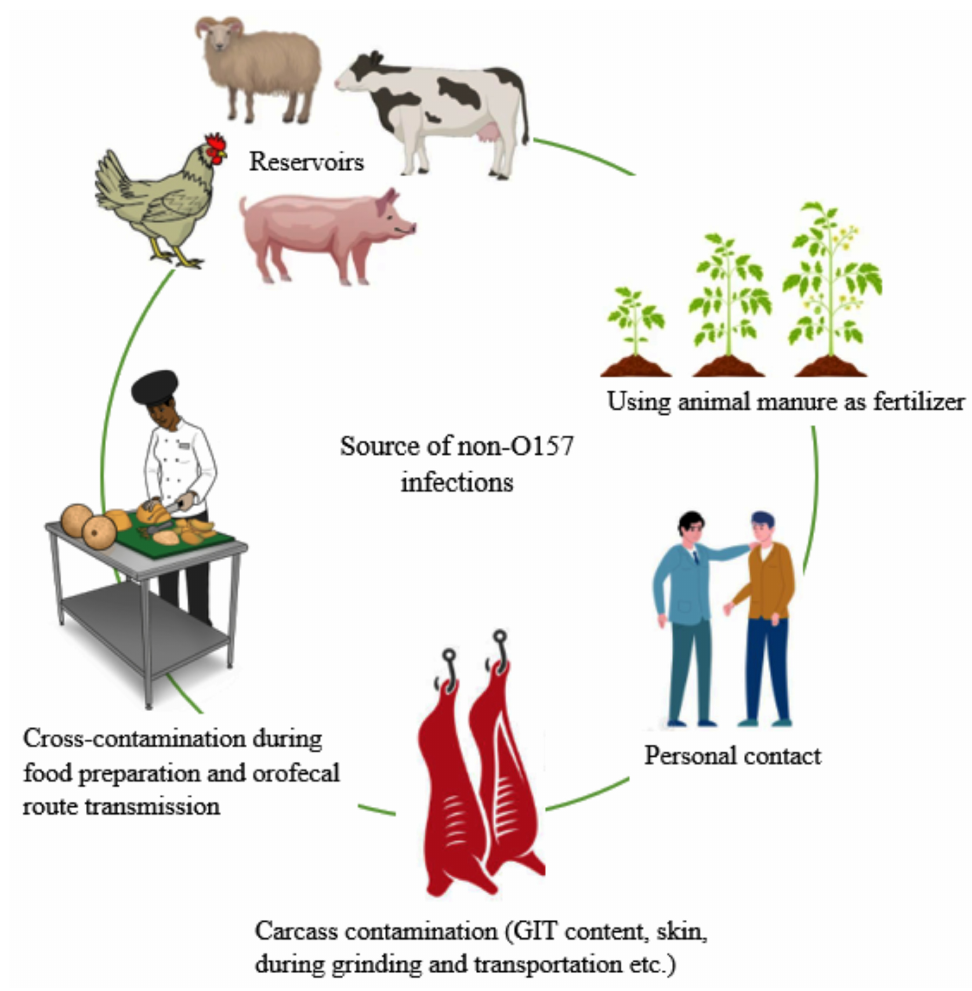
Figure 1. The major source of infections associated with non-O157 E. coli